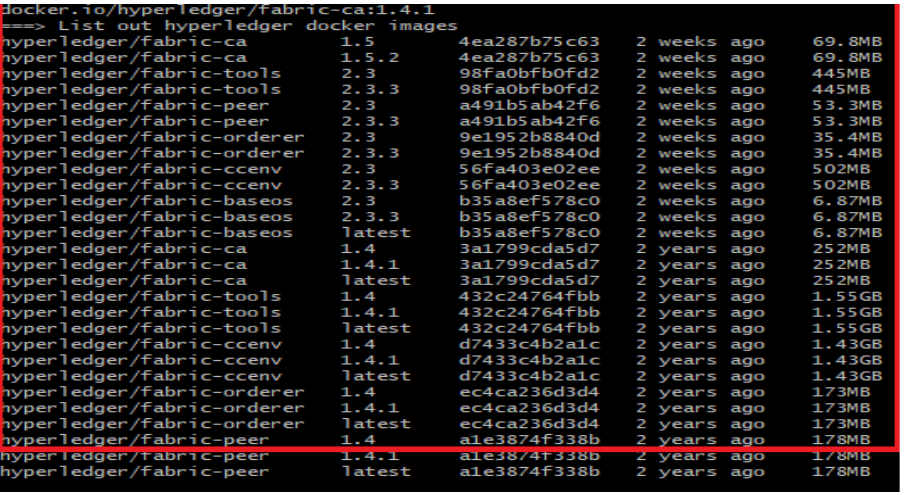
Figure 21. Docker list in fabric